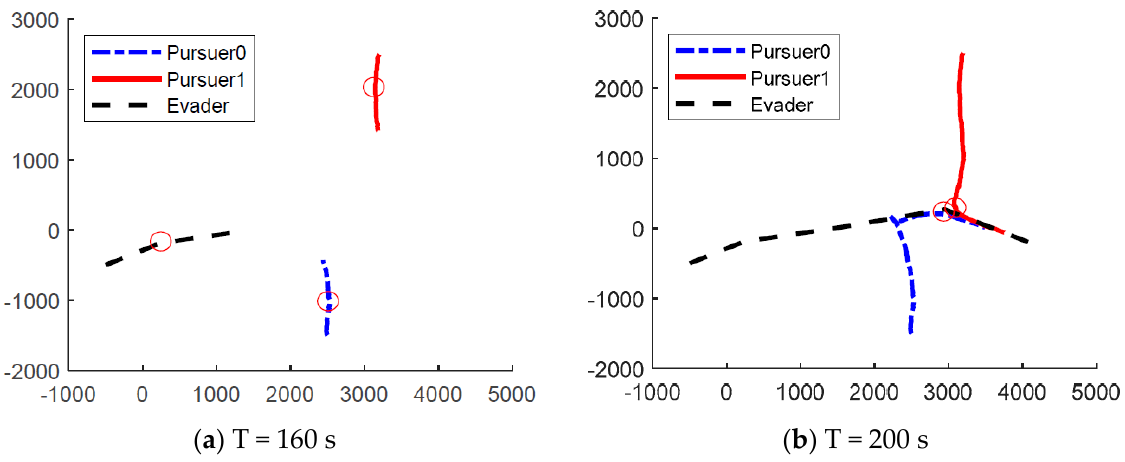
Figure 16. The traces of 𝑃 (cid:2868) , 𝑃 (cid:2869) and 𝐸 (cid:2868) under the SK-FACL when 𝐸 (cid:2868) was